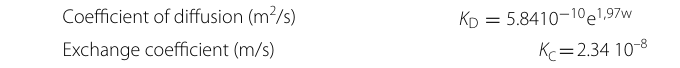
Table 4 The data used in the diffusion model Coefficient of diffusion (m 2 /s)